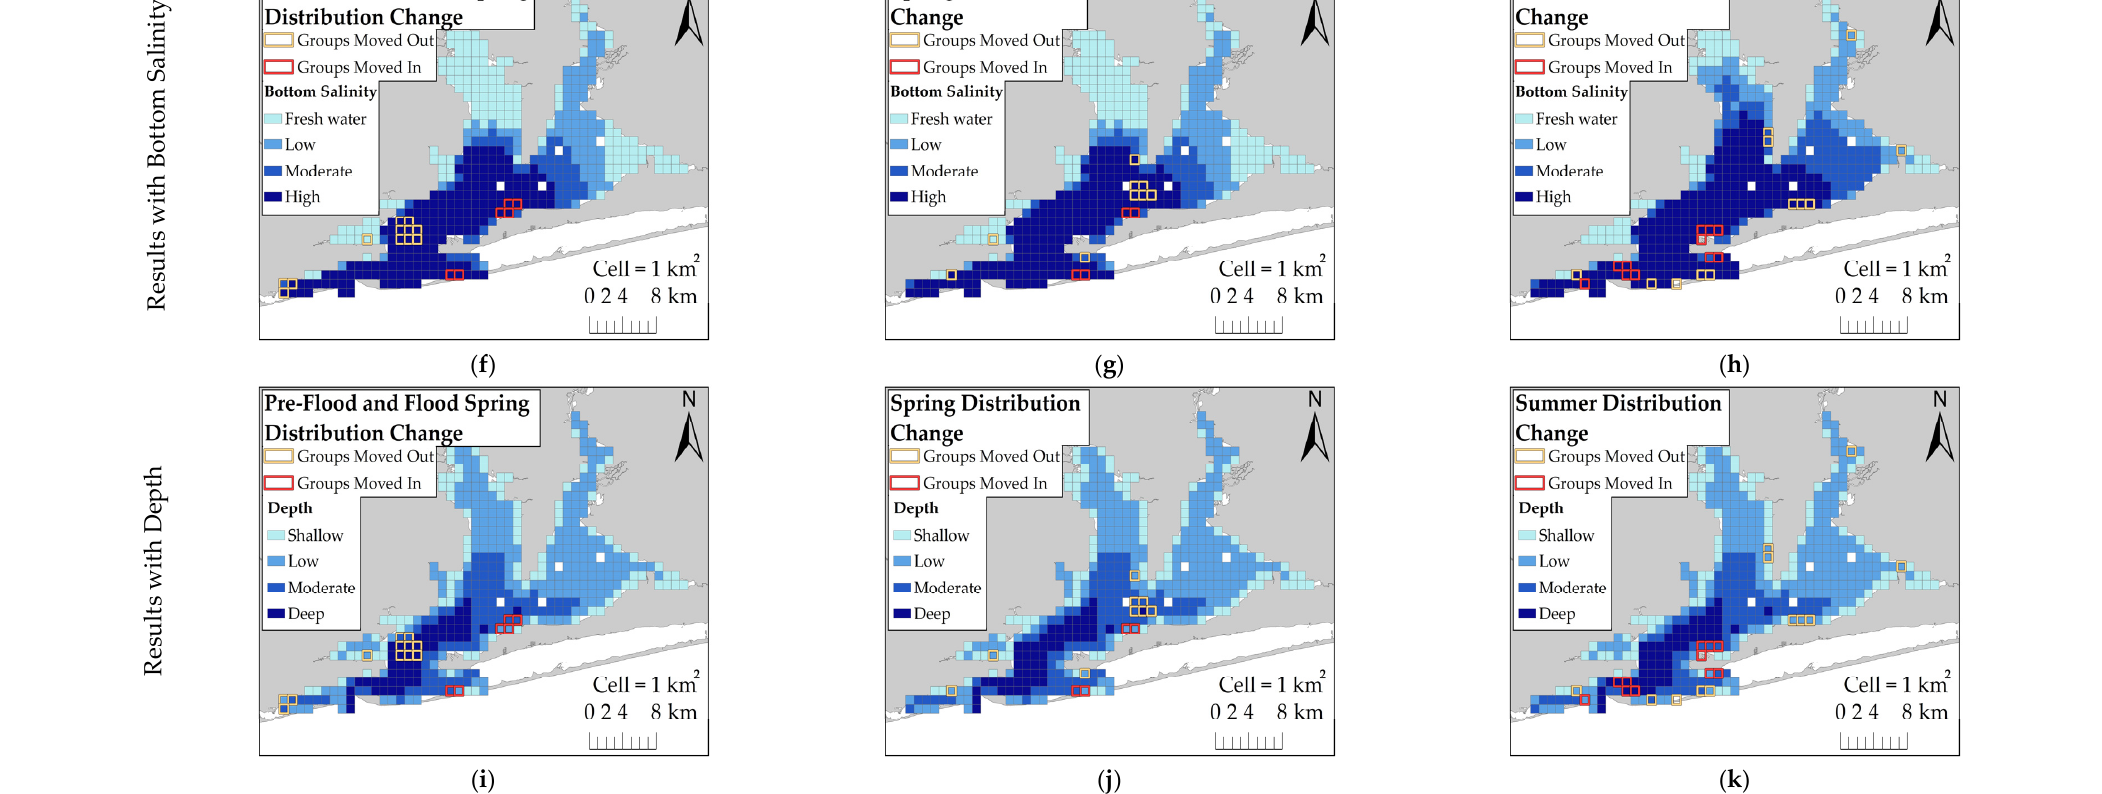
Figure 3. Kernel density estimates (KDEs) of dolphin group density for: ( a ) Pre-Flood Spring; ( b ) Control Spring; ( c ) Control Summer; ( d ) Flood Spring; and ( e ) Flood Summer. Baseline distributions ( a ‒ c ) are sessions that were not affected by the flood event. Flood-impacted sessions ( d , e ) are sessions affected by the flood event. Legend in ( a ) applies to all KDE figures ( a ‒ e ). Significant changes (>2 SD) in estimated dolphin group density in relation to bottom salinity during flood-impacted sessions are shown for: ( f ) Pre-Flood Spring vs. Flood Spring; ( g ) Control Spring vs. Flood Spring; and ( h ) Control Summer vs. Flood Summer. Ranges for bottom salinity categories are: Freshwater (<5 ppt), low (5 ‒ 11 ppt), moderate (12 ‒ 20 ppt), and high (>20 ppt). Significant changes (>2 SD) in estimated dolphin group density in relation to depth are shown for: ( i ) Pre-Flood Spring vs. Flood Spring; ( j ) Control Spring vs. Flood Spring; and ( k ) Control Summer vs. Flood Summer. Ranges for depth categories are: shallow (<1 m), low (1 ‒ 3 m), moderate (4 ‒ 6 m), and deep (7 ‒ 11 m). The freshwater surface layer was 3 m deep throughout the entire estuary in Flood Spring, but it started to recede northward during Flood Summer. Dolphins moving into an area during a flood-impacted session are represented by red outlined cells and dolphins moving out of an area during a flood-impacted session are represented by orange outlined cells (applies to figures f ‒ k ).